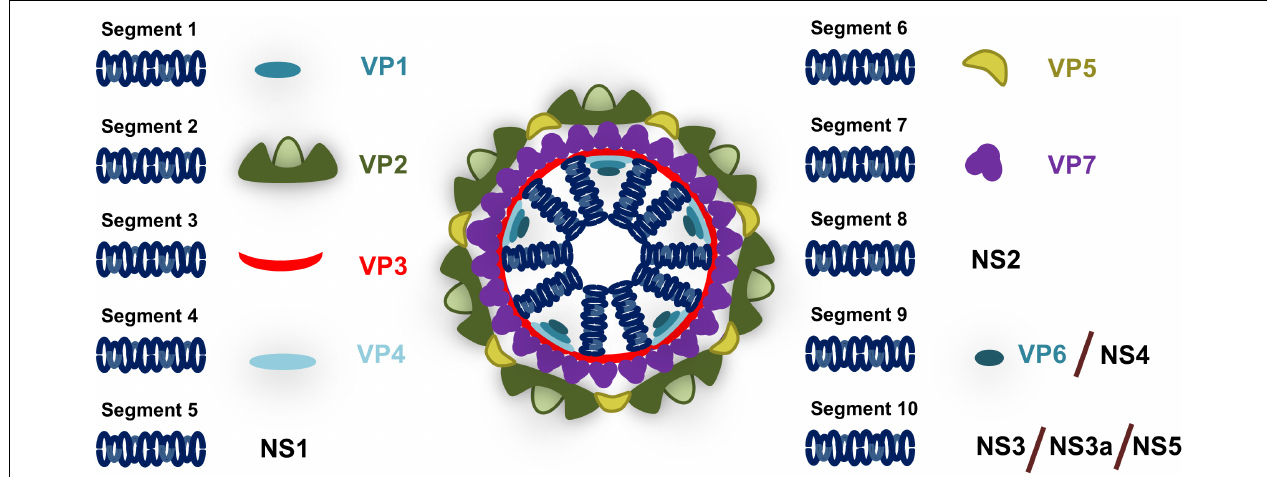
FIGURE 2 | Schematic of BTV particle. BTV genome consists of 10 segments that encodes for structural proteins (VP) present in the viral particle and non-structural proteins (NS) that are expressed during infection. Segment 1 encodes for the RNA polymerase VP1; Segment 2 for the outer capsid protein VP2; Segment 3 for the inner core protein VP3; Segment 4 for the RNA capping enzyme and methyl transferase VP4; Segment 5 for NS1 which is responsible for the formation of tubular structures during infection; Segment 6 for the outer capsid protein VP5; Segment 7 for the inner core protein VP7; Segment 8 for the RNA binding protein NS2 that is involved in inner core formation; Segment 9 for RNA helicase VP6 and for NS4 which acts as an IFN antagonist; and Segment 10 for NS3 (and its isoform NS3a) which is involved in virion egress and IFN antagonism and putatively for NS5 that could be involved in cell